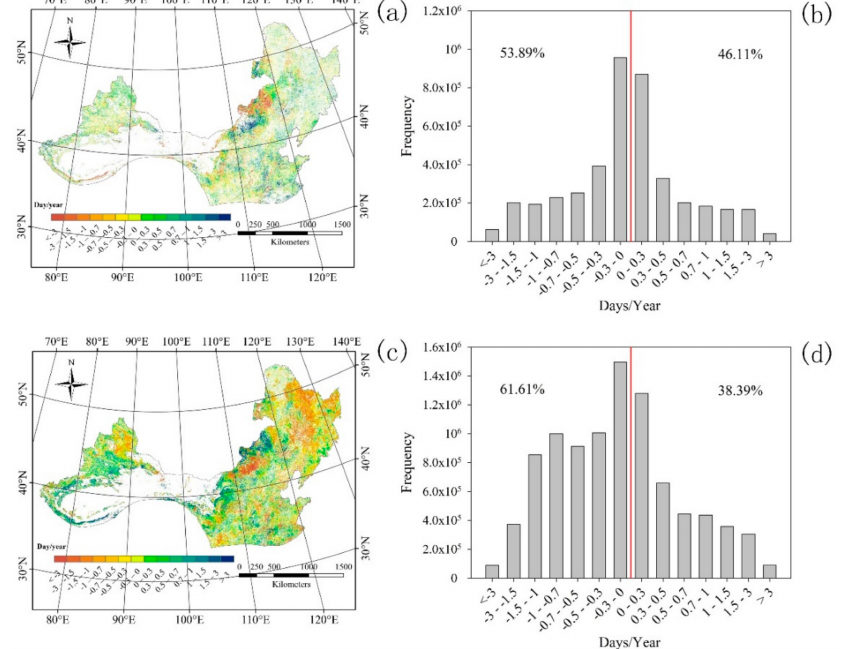
Figure 2. Isolated impacts of climatic factors ( a ) and non-climate change ( c ) on the variation in the SOS. ( b , d ) are the corresponding frequency distributions for climatic factors ( a ) and non-climate change ( c ), respectively.